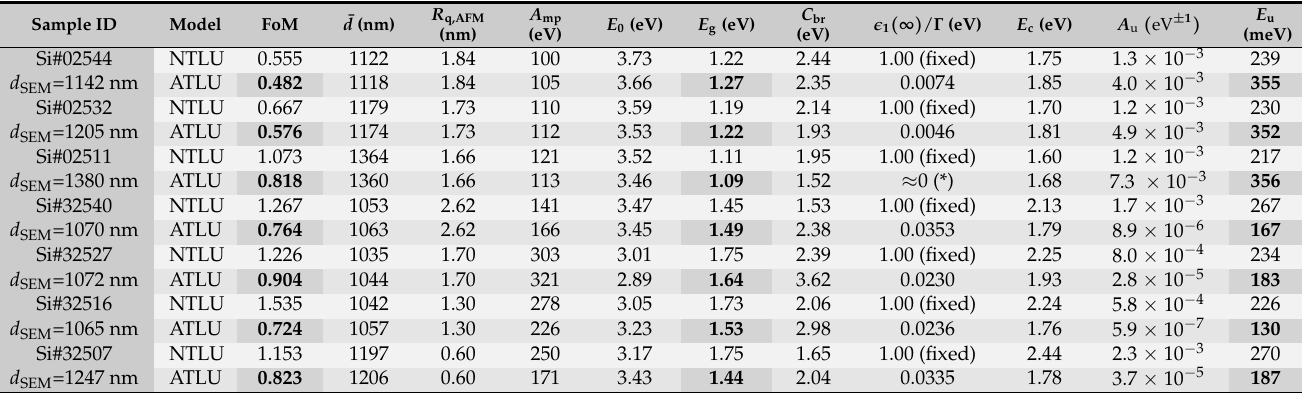
Table 1. Values of all the ATLU model parameters for RFMS- a -Si thin layers, each prepared with a different Ar-gas pressure. In the sample identification (ID) code, the first adopted three numbers indicate the deposition temperature in degrees Celsius, whereas the next two numbers show the Ar-working pressure during the deposition in the particularly chosen unit decipascal. In addition, the values of the adopted cost or merit function, FoM, for those a -Si samples under study are presented. The values of the Urbach energy and amplitude, E u and A u , respectively, obtained from the previous ATLU-model parameters, are also listed in the table. On the other hand, the value of the geometrical parameter ¯ d ( ≡ d for these a -Si samples), is also indicated. The best-fit values for ∆ d are not shown in the table, since they are practically zero in all the roughly 1.1- µ m-thick-specimens investigated; only layers with thickness about or less than 800 nm exhibited a fitted value of ∆ d > 0. Moreover, the experimentally determined values of the surface roughness parameter, R q,AFM , for the seven a -Si specimens are also presented. In addition, the film thickness, d SEM , measured from the cross-sectional SEM micrographs corresponding to the present a -Si specimens under study, are also